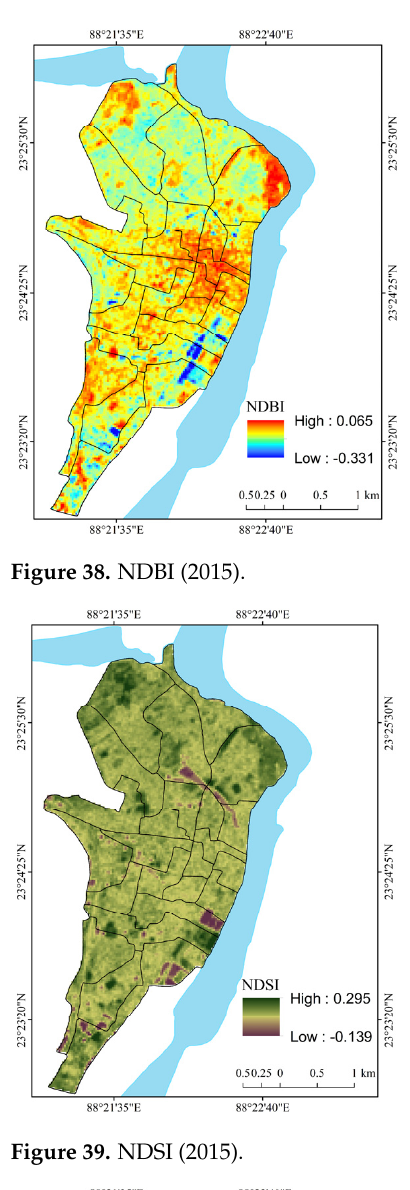
Figure 37. MNDWI (2015).